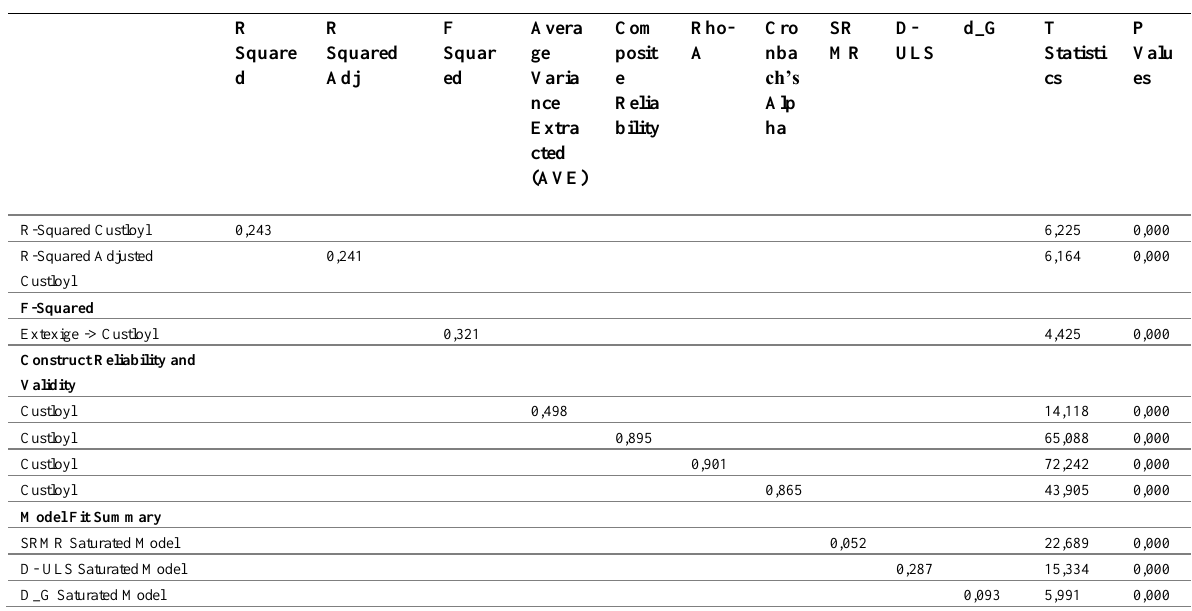
Table 3: Model Fitness and Quality Indices